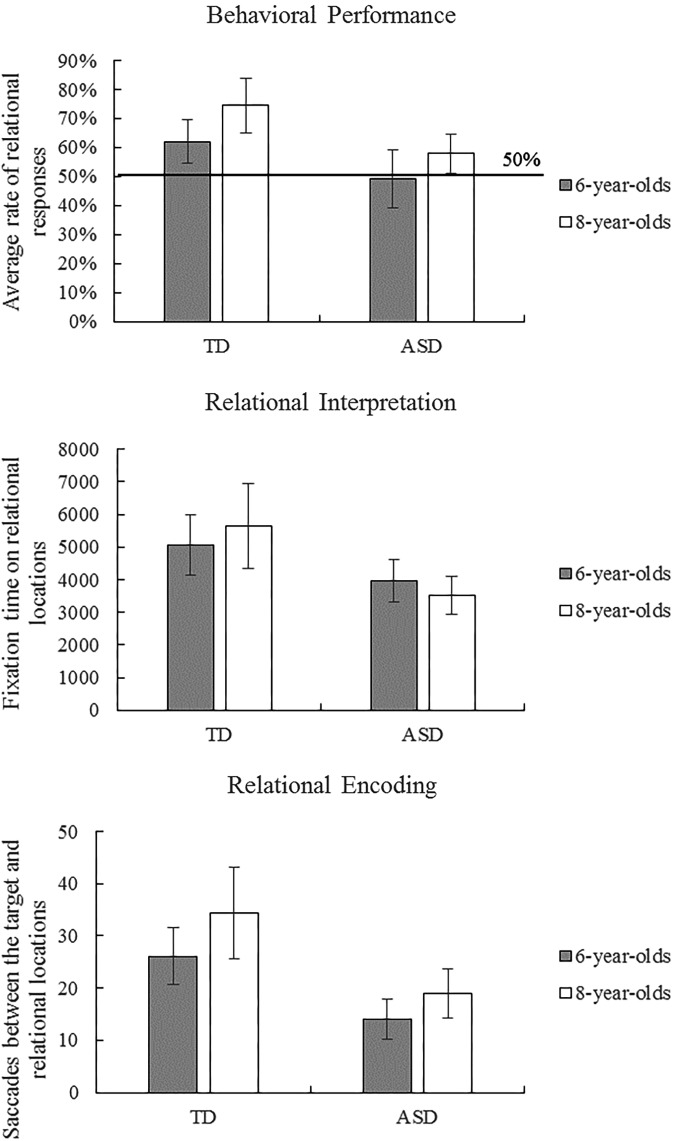
Autism spectrum disorder (ASD) and typically developing (TD) children’s average behavioral performance and eye-movement patterns across three scene analogy tasks. Error bars represent 95% CI of the mean.